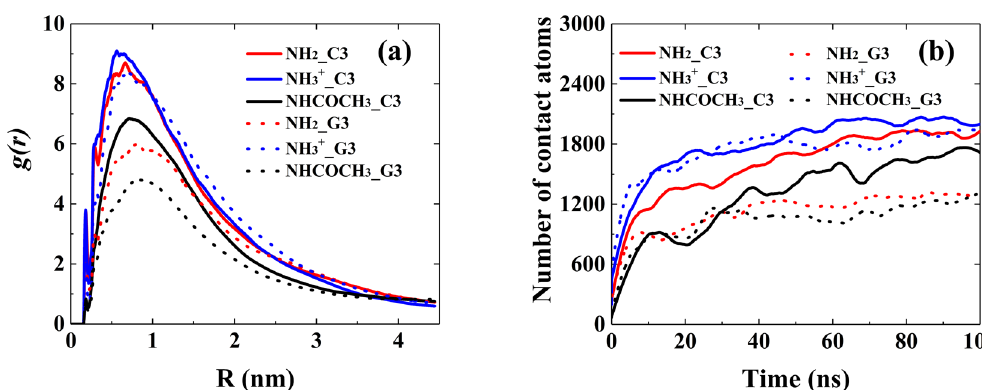
Figure 2. ( a ) The RDFs of C3 and G3 around different functional groups in chitosan ( b ) Number of contact atoms between chitosan and C3/G3 as a function of simulation time, with the ratio chitosan:C3/G3 =